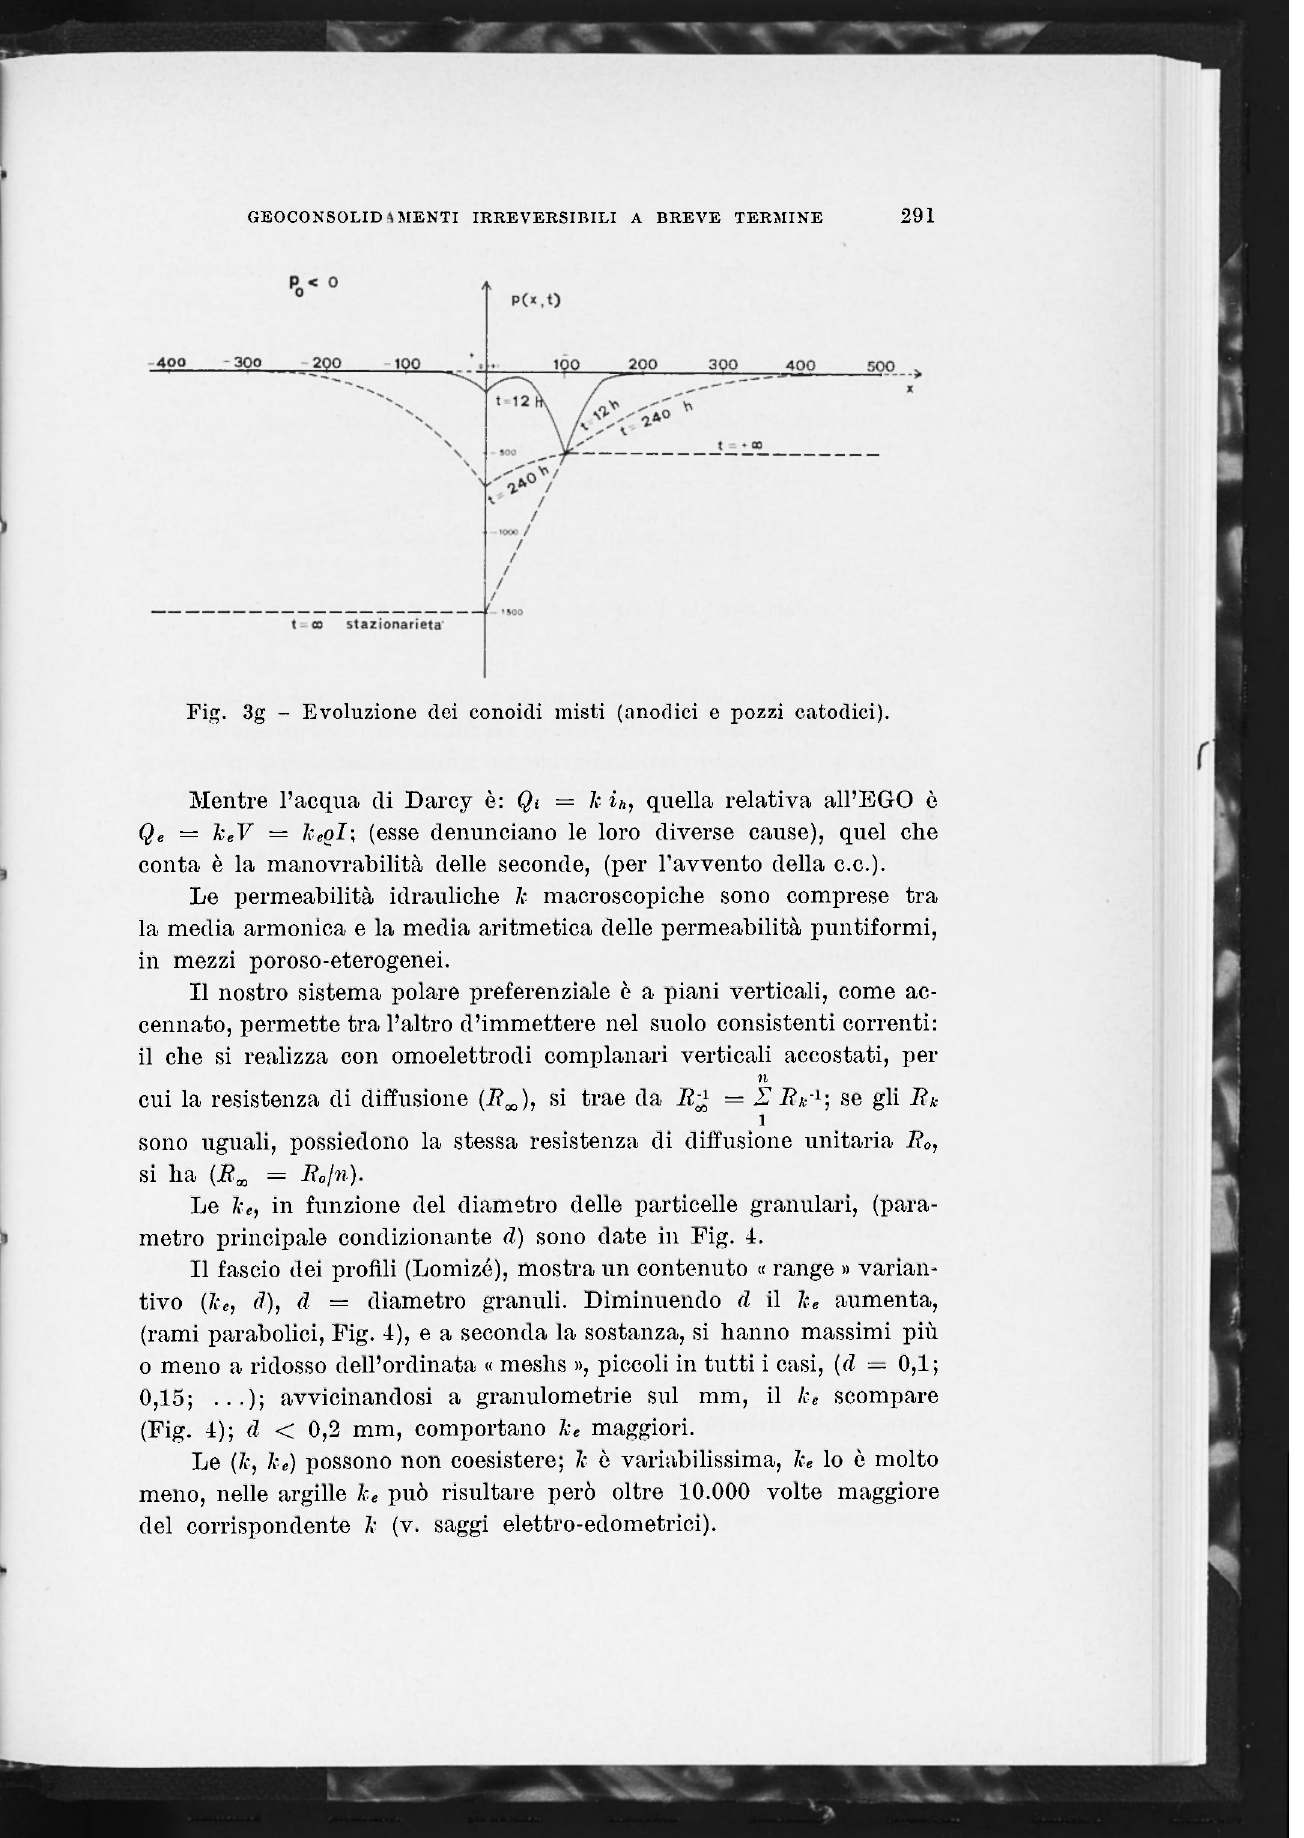
Fig. 3g - Evoluzione dei conoidi misti (anodici e pozzi